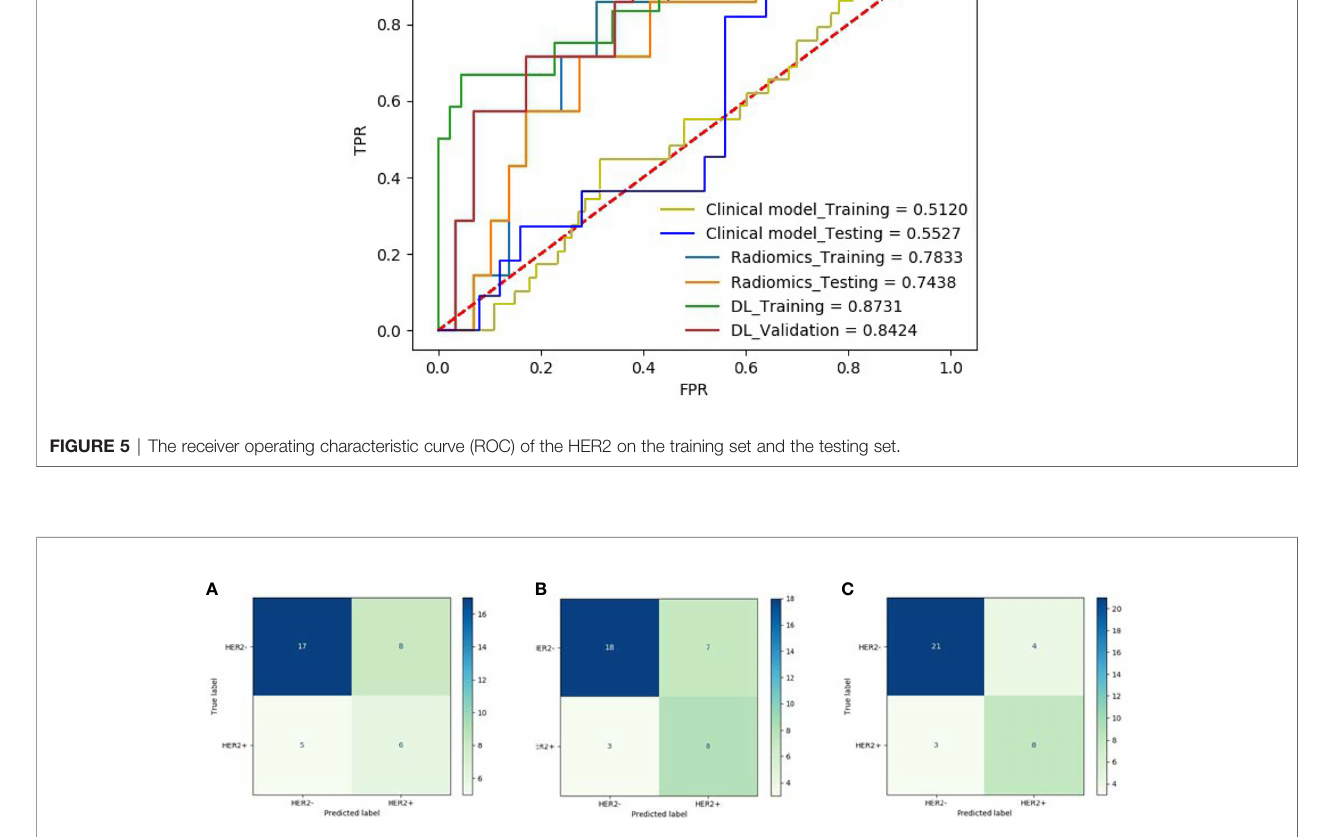
FIGURE 6 | Confusion matrix: (A) clinical model; (B) radiomics model; (C) DL model.